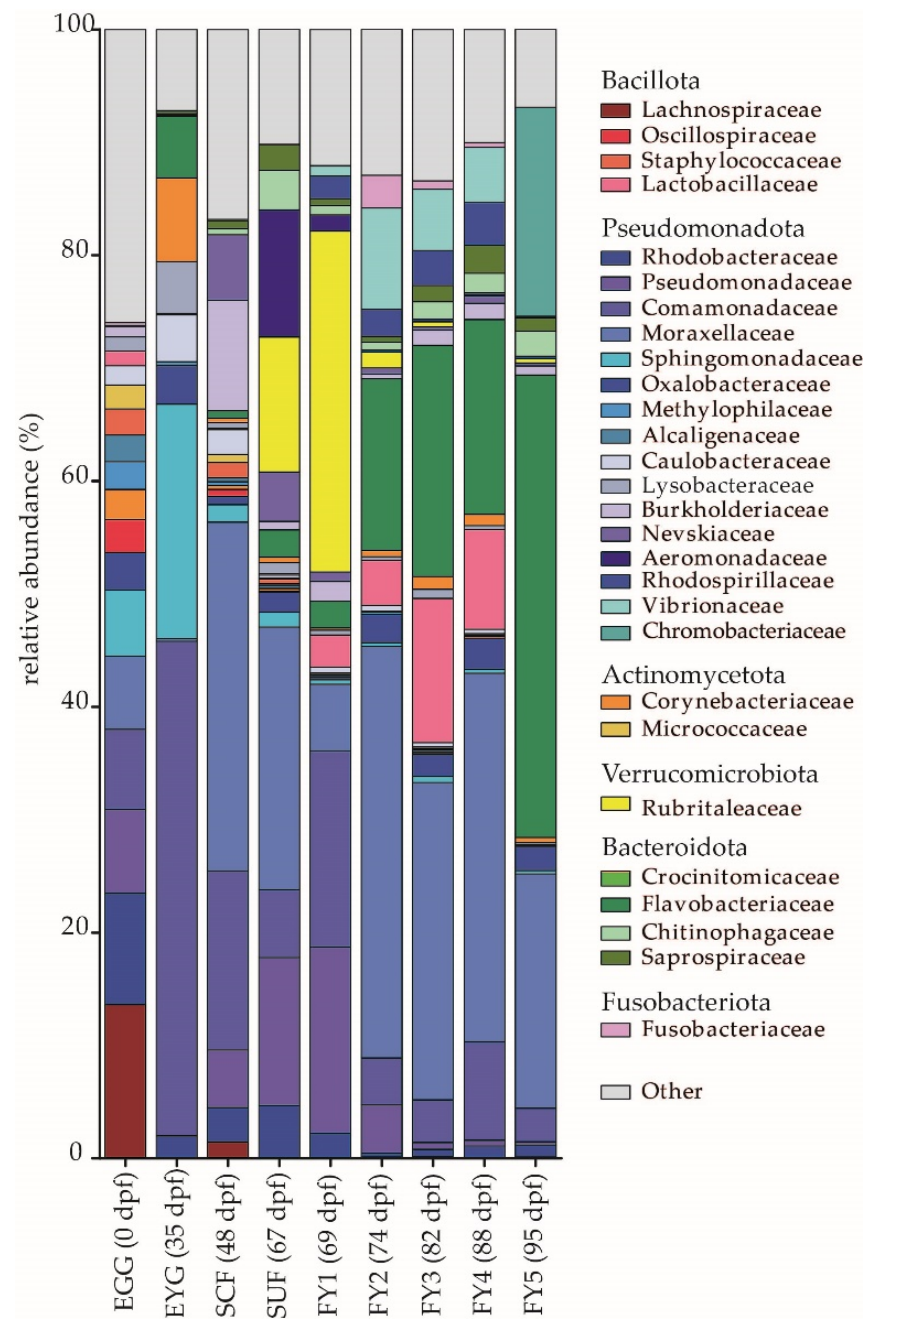
Figure 4. Bacterial families with a relative abundance of 2.0% or higher in at least one stage in the BC shown for all developmental stages. EGG, egg; EYG, eyed egg; SCF, sac fry; SUF, swim-up fry; FY1, fry 69 dpf; FY2, fry 74 dpf; FY3, fry 82 dpf; FY4, fry 88 dpf; FY5, fry 95 dpf; dpf, days post